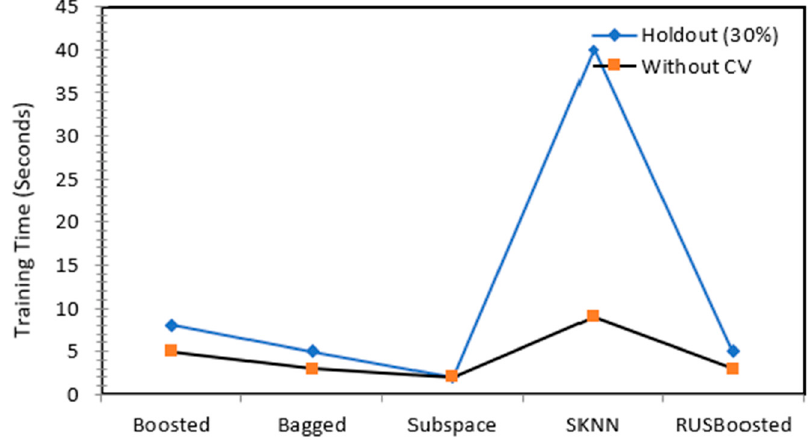
Figure 8. Training time comparison between the holdout method and no validation after performing the dimensionality reduction. Table 4. Ensemble accuracies with dimensionality reduction versus CV.